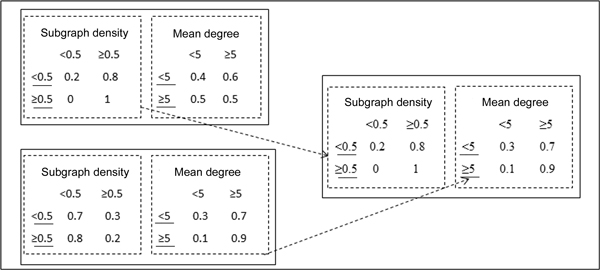
Mutation operation for the example FCFM. This has been implemented as a two steps process. In the first step a), a parameter is randomly selected and its value is randomly changed to a value in the interval [0, 1]. In the second step b), the parameters in the row of the parameter changed in the previous step, are divided by their row sum, in order to maintain their sum as equal to 1.